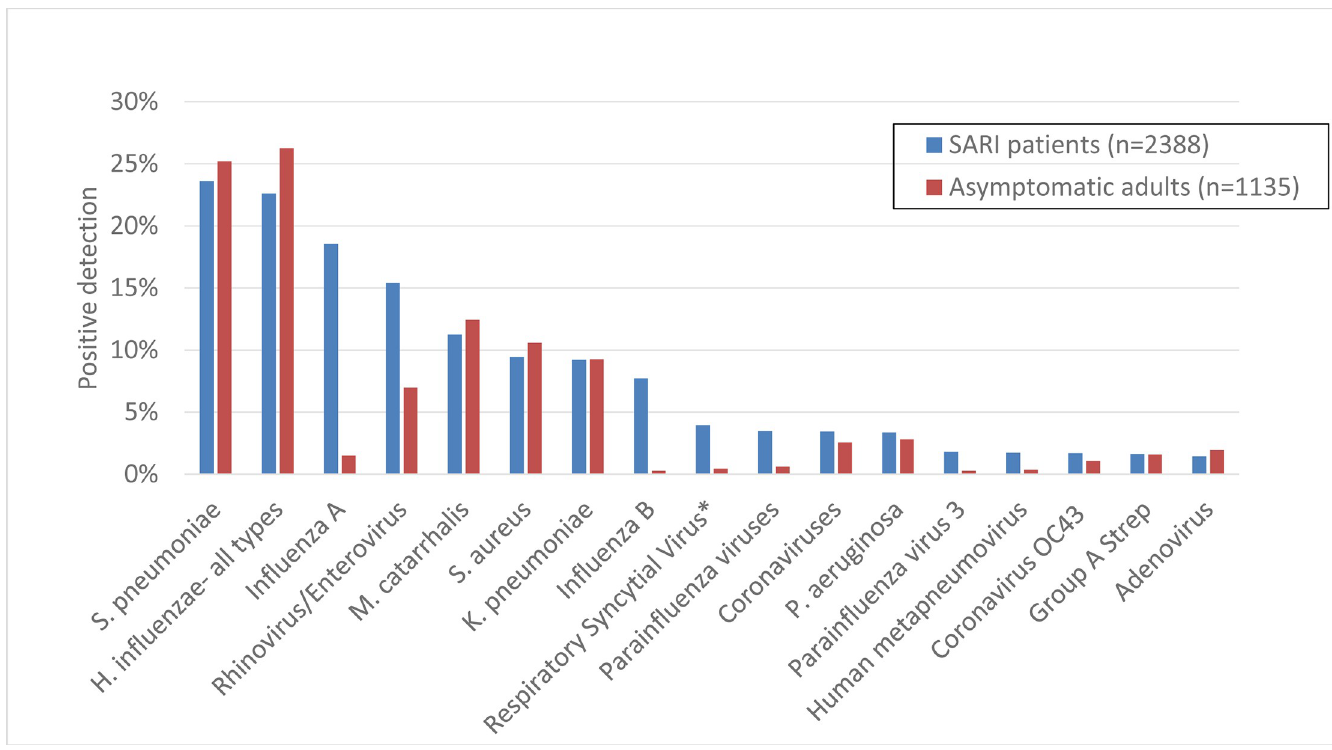
(18.6% of SARI patients vs. 1.5% of asymptomatic adults), influenza B (7.7.% vs. 0.3%), rhino/ enteroviruses (15.4% vs. 7.0%), and respiratory syncytial virus (RSV) (4.0% vs. 0.4%). Thai- land, Guatemala, and Bangladesh had the highest prevalence of RSV detections among SARI patients (9.0%, 4.3%, and 3.4%, respectively). Two or more pathogens were detected in 39.5%